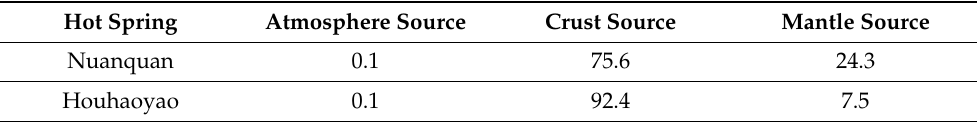
Table 1. The contribution rate of three different source in the value of 3 He/ 4